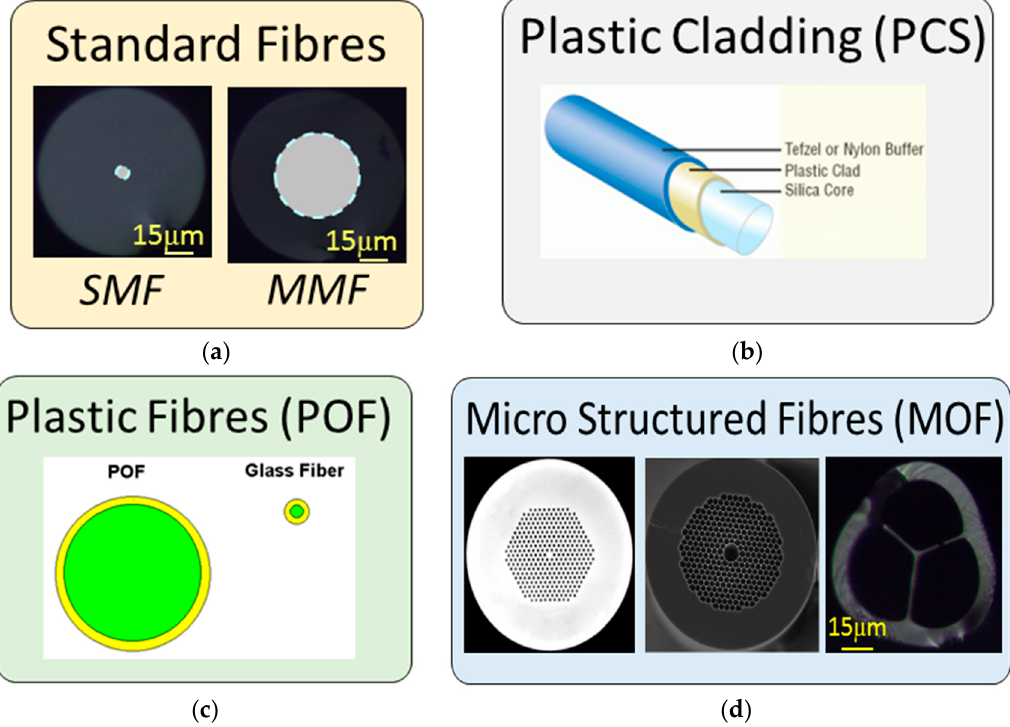
Figure 2. Diagram showing the type of fibres that are commonly used to prepare sensors.